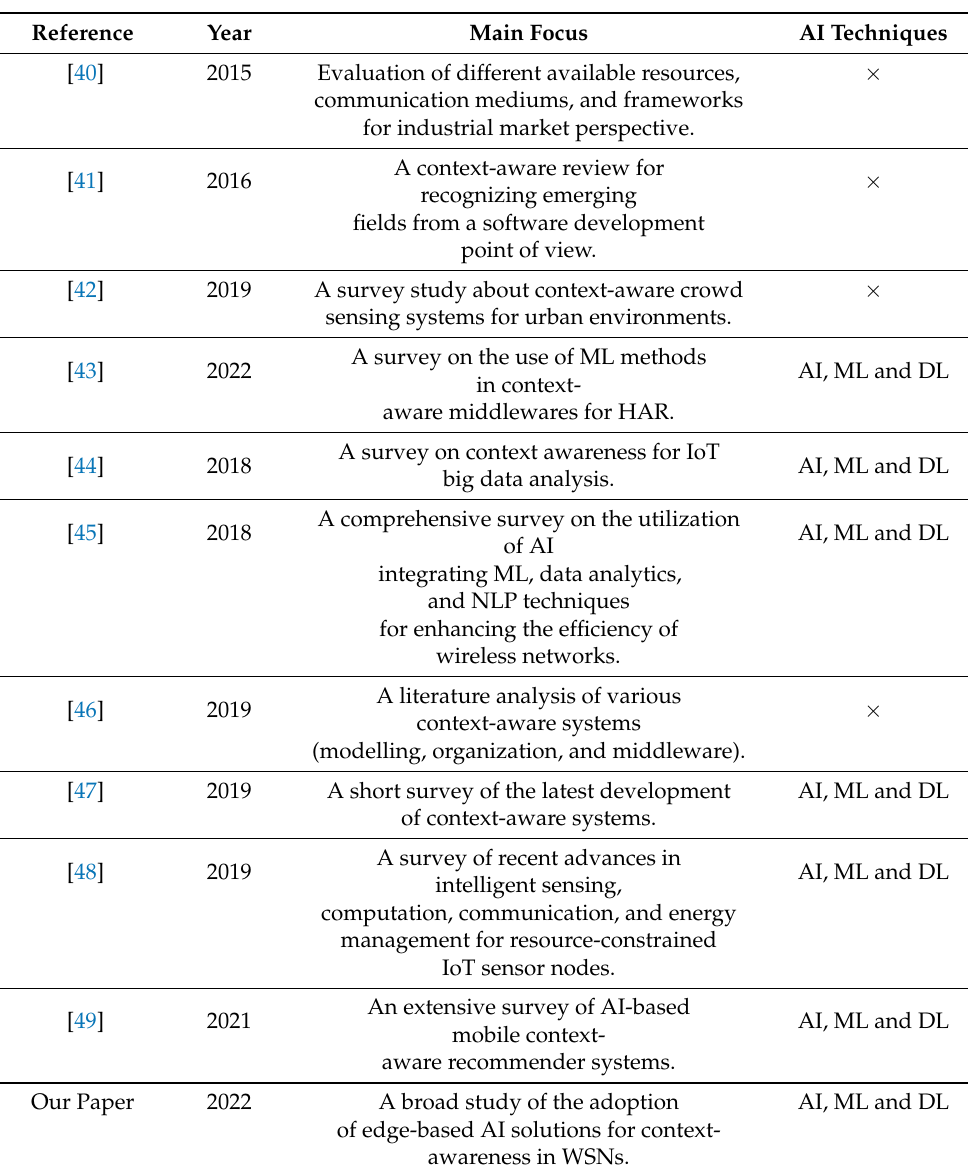
Table 1. Overview of previous related surveys and comparison with our study with respect to their contributions and discussed intelligent techniques (classical AI, ML and